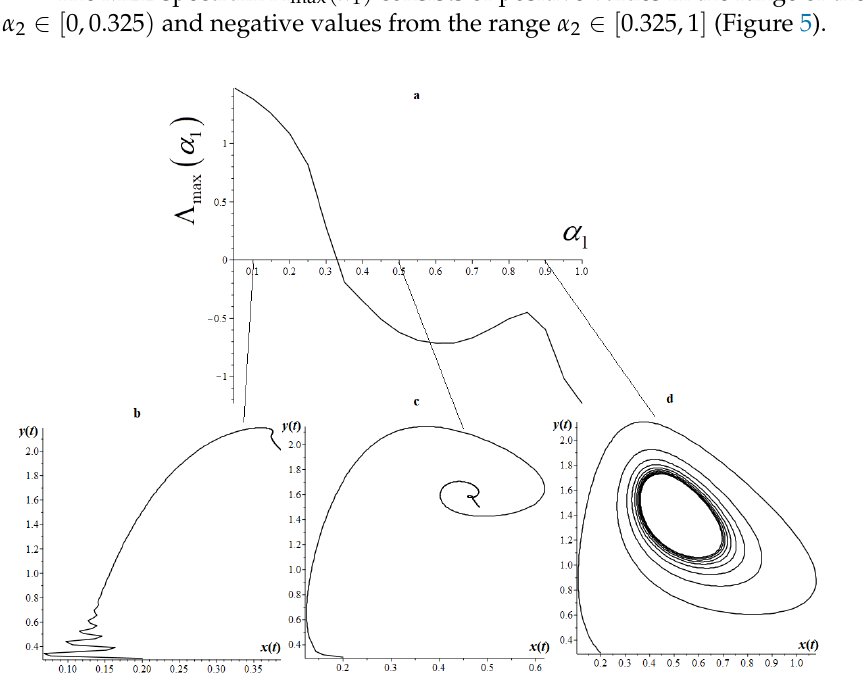
Figure 5. ( a ) — Spectrum MLE Λ max ( α 1 ) ; ( b ) — phase trajectory for α 1 = 0.1; ( c )—phase trajectory for α 1 = 0.5; ( d ) — phase trajectory for α 1 =